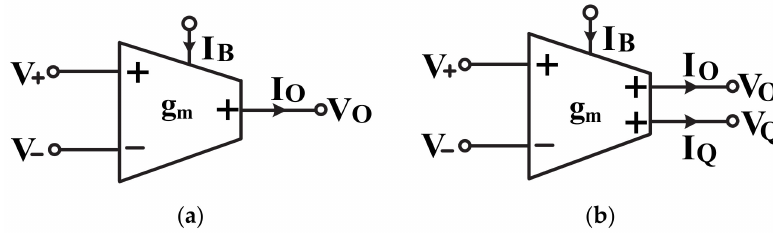
Figure 1. Symbol of the OTA. ( a ) Single-ended output OTA and ( b ) DO-OTA.